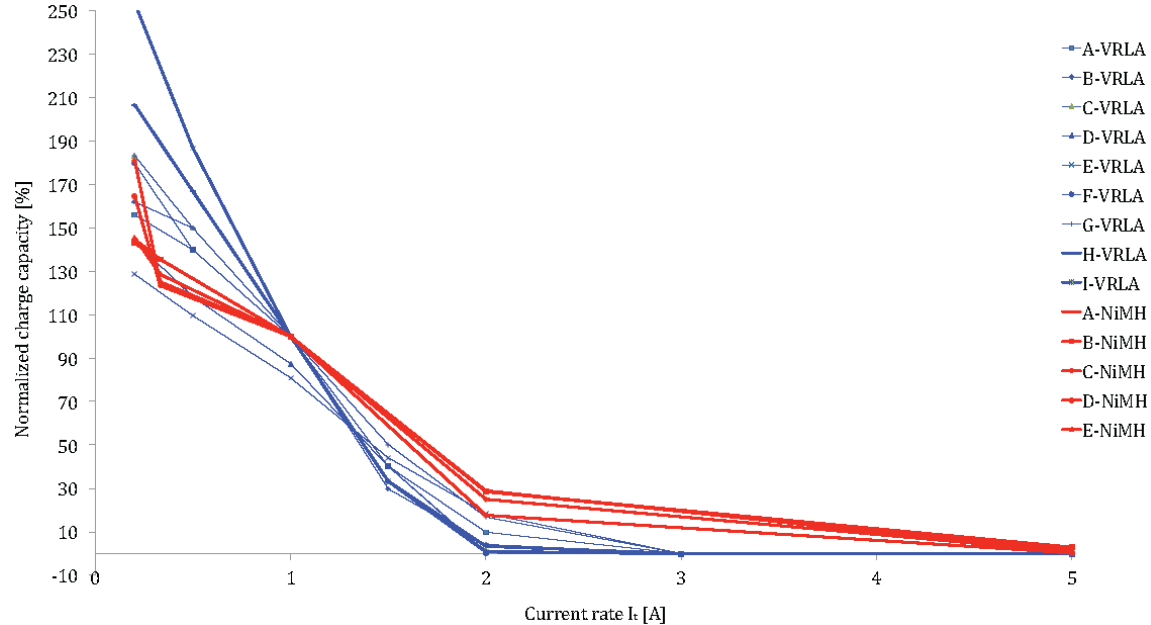
Figure 22. Charge performances of VRLA and NiMH battery technologies at different current